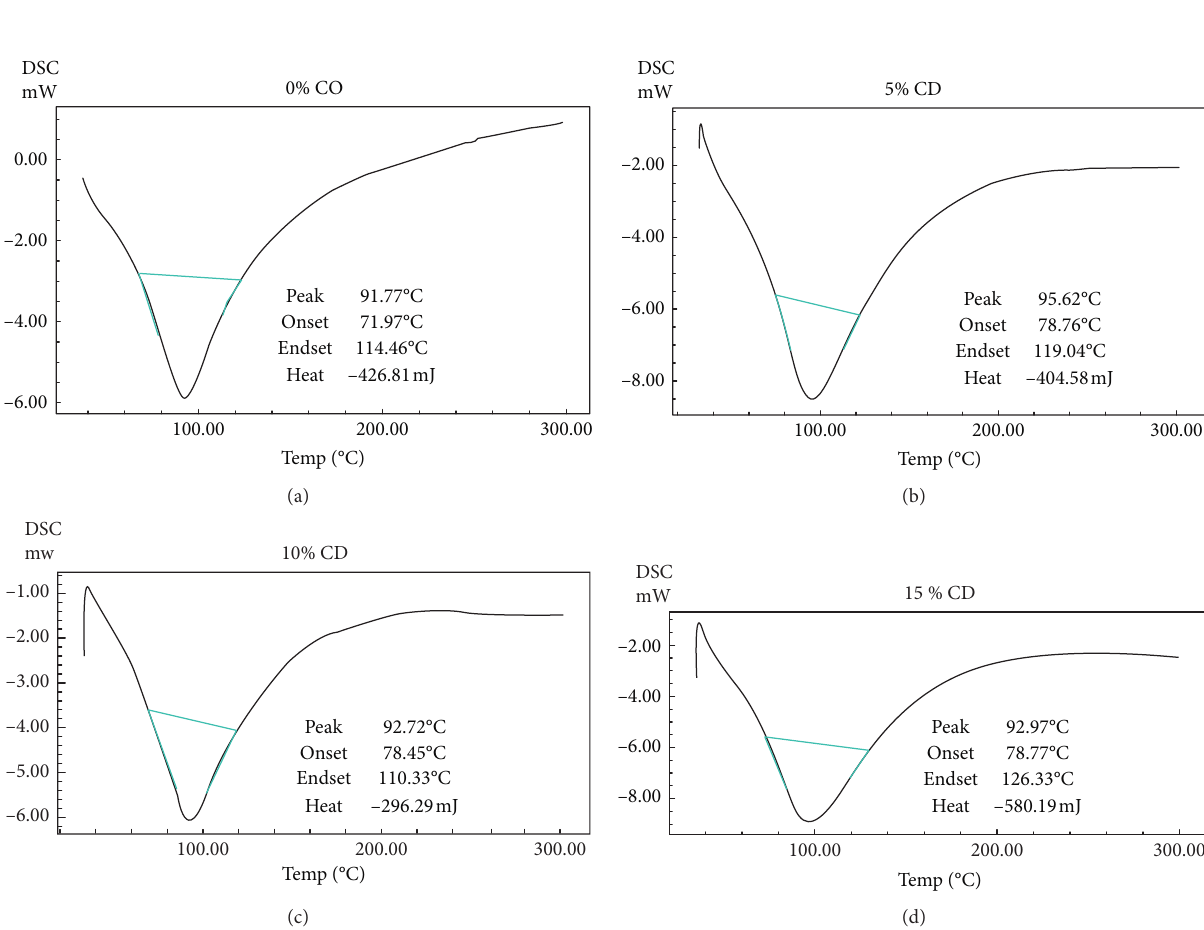
Figure 7: (a) Differential Scanning Calorimetry (DSC) analysis of Control of group 2. (b) Differential Scanning Calorimetry (DSC) analysis of experimental GIC 4. of group 2 (with 5% dentin ceramic powder). (c) Differential Scanning Calorimetry (DSC) analysis of experimental GIC 5. of group 2 (with 10% dentin ceramic powder). (d) Differential Scanning Calorimetry (DSC) analysis of experimental GIC 6 of group 2 (with 15% dentin ceramic